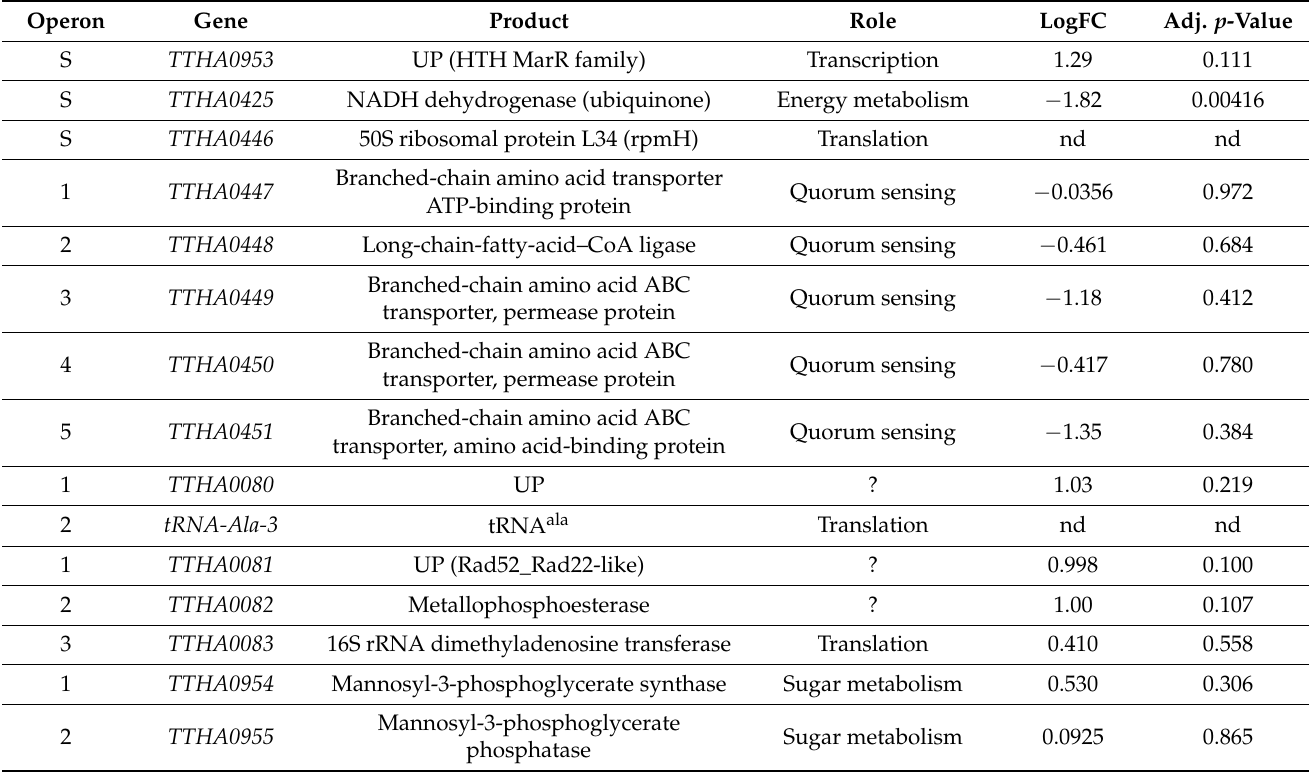
Table 3. Bioinformatic data for FIMO-identified, TTHA1359-regulated